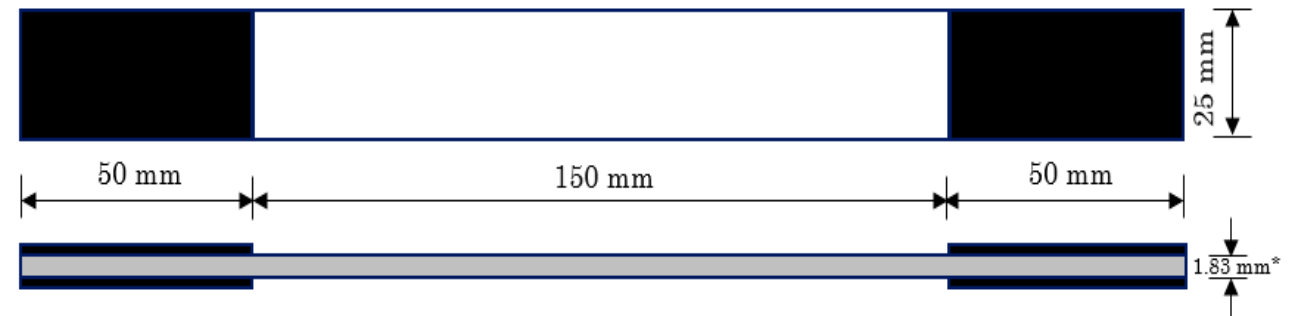
Figure 2. Specimen Figure 2. Specimen dimensions.